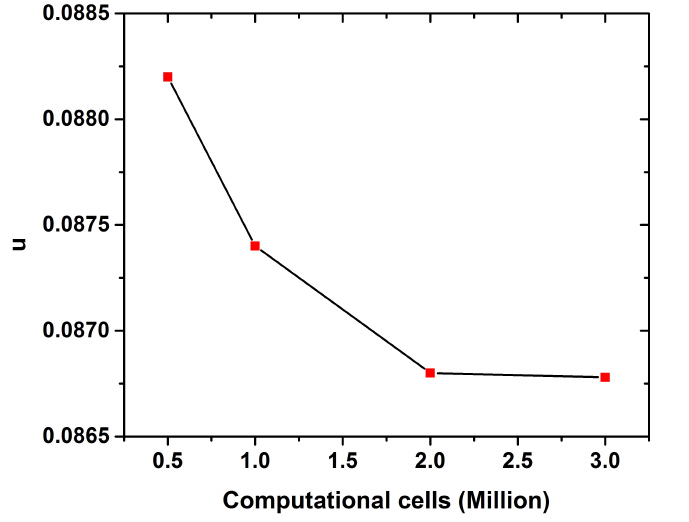
Figure 2. Velocity in the outlet 1 of the carotid model under different number of computational cells for the representative case of m = 0.5.